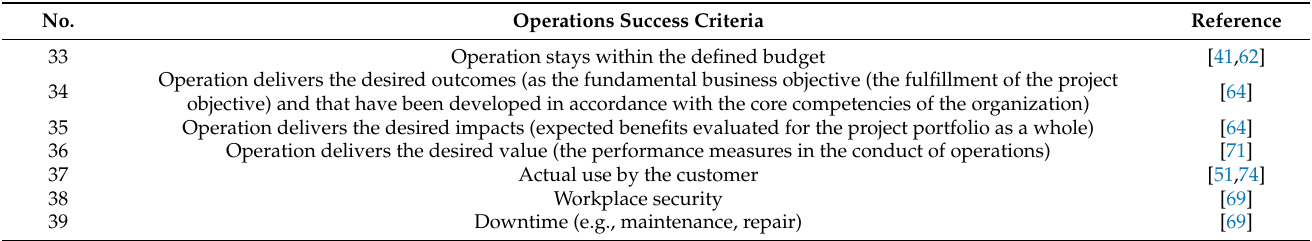
Table 4. Operations Success